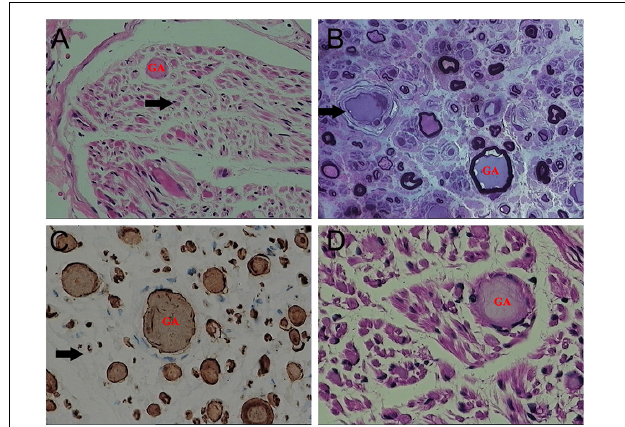
FIGURE 2 | Microscopic examination of the patient’s sural nerve revealed a giant axon (GA). (A) HE staining revealed tumefaction of the neural axon and a few regenerating clusters (arrow). (B) Part of the axon atrophied mildly, and the vascular wall (arrow) was thickened and layered. (C) A myelinated nerve fiber (arrow) is slightly reduced. (D) No obvious increase in glycogen was